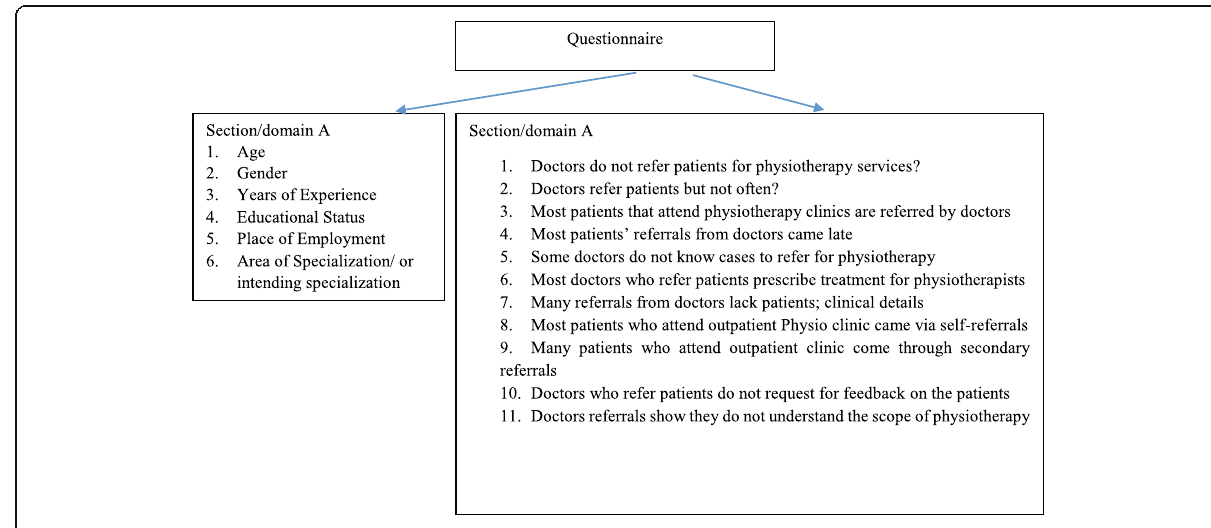
Fig. 1 Contents of the questionnaire used in the present